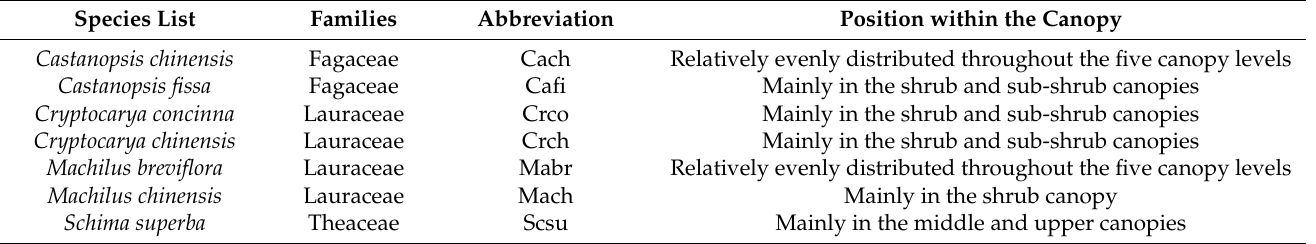
Table 1. Information of families, abbreviation and position within the canopy in the study plot of each target